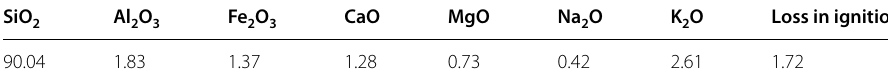
Table 3 Chemical composition of RHA (Wt.